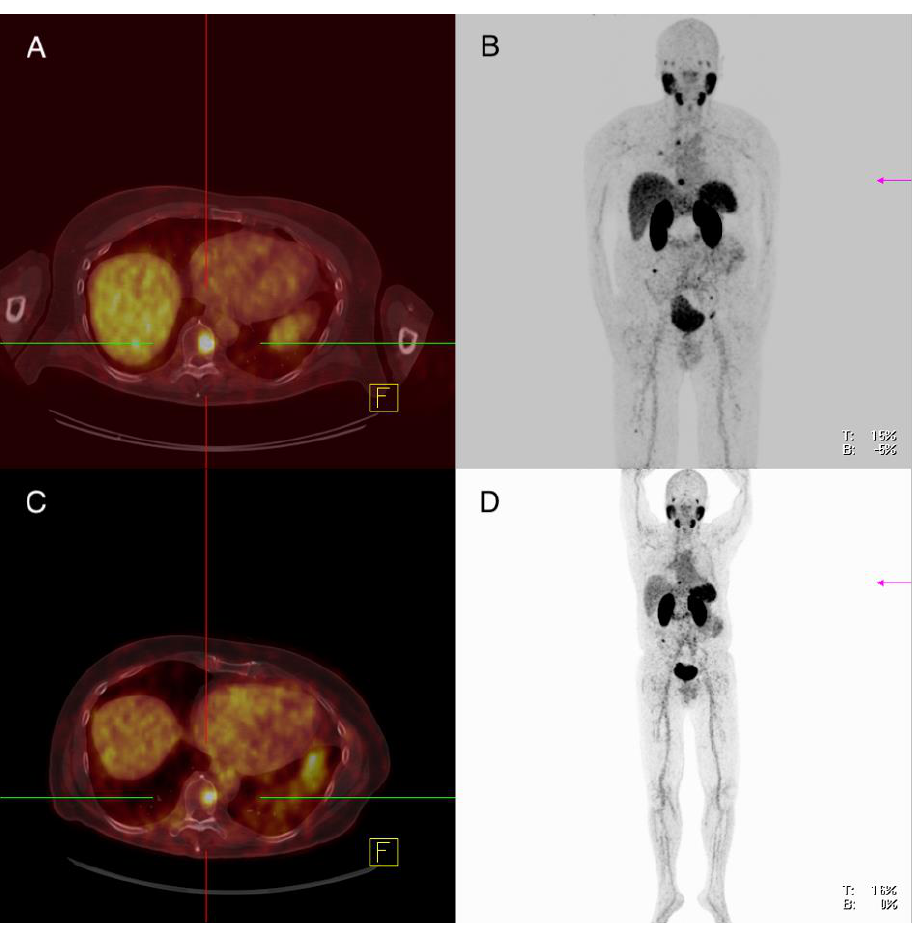
Figure 7. Patient 8. Second 68 Ga-PMSA-PET/CT ( A , B ), first 68 Ga-PMSA-PET/CT ( C , D ). Second 68 Ga-PSMA-PET/CT: Progressive disease with size progression of known osseous lesions and multiple new osseous lesions with increased PSMA expression.